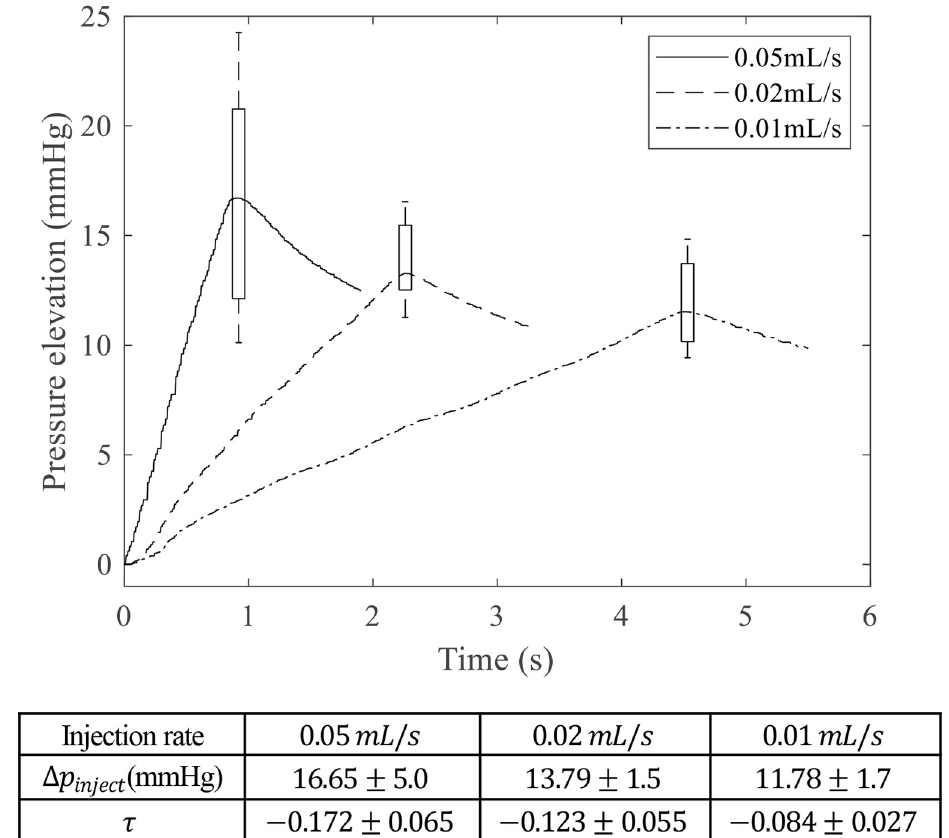
Fig 6. Pressure elevation and relaxation according to injection rate. The maximum pressure values were also represented by a Whisker plot. Each subgroup contains 30 samples.